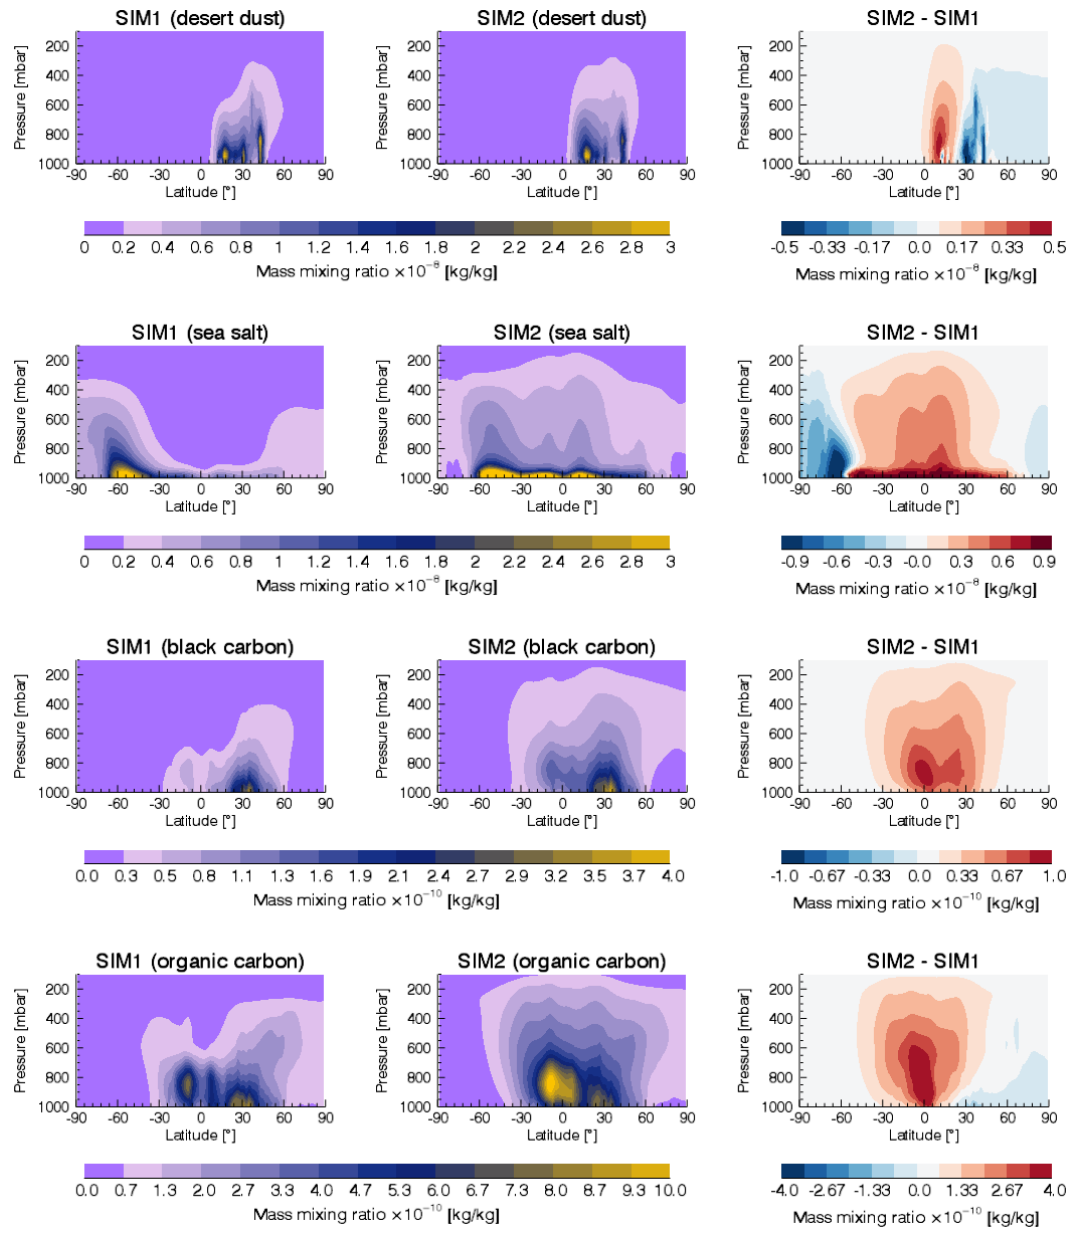
Figure 3. The annual and zonal mean vertical profiles of mass mixing ratios of all aerosol species in the CTM MOCAGE: for SIM1 on the left, for SIM2 in the middle, and their difference on the